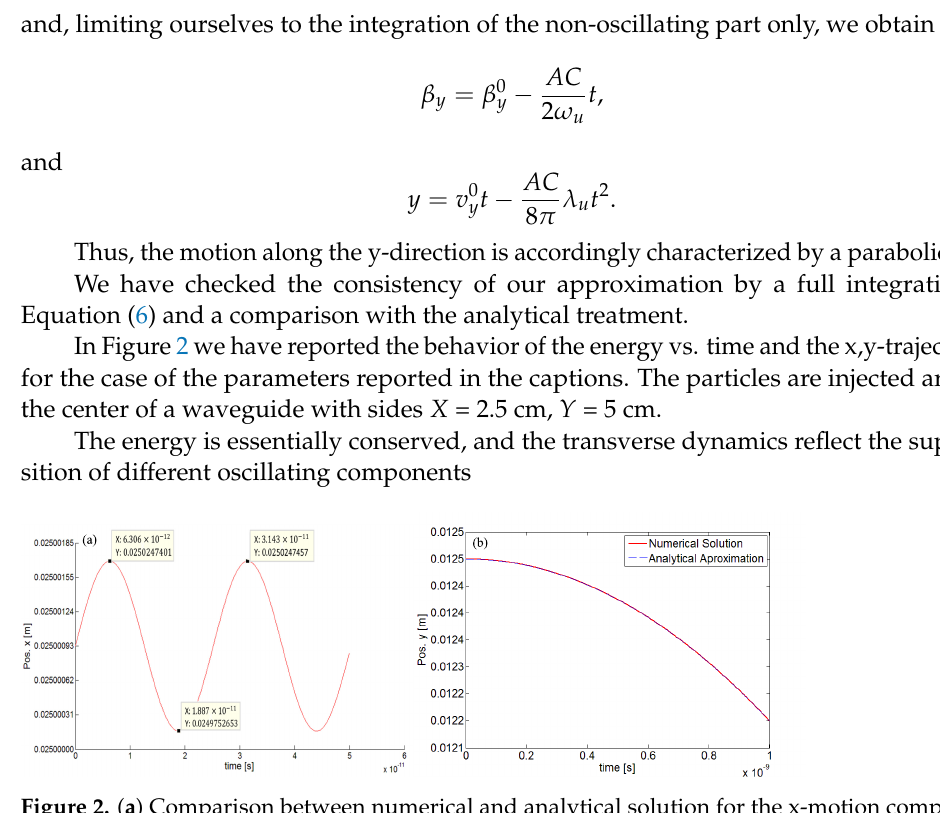
Figure 2. ( a ) Comparison between numerical and analytical solution for the x-motion component; ( b ) same as ( a ) for the y-position (simulation